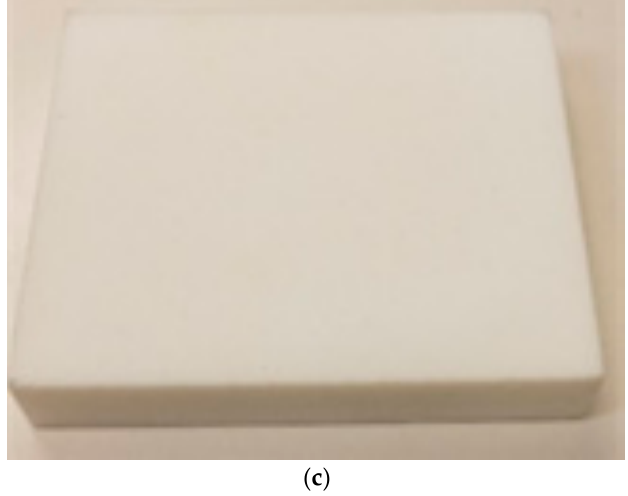
Figure 6. Images of three test samples: ( a ) gauge block; ( b ) brushed aluminum; ( c ) SLS printed part.